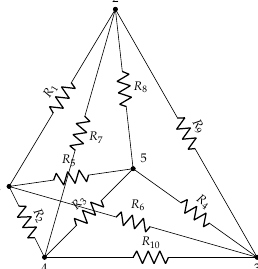
Figure 3. Multi-connected resistive grid configuration.